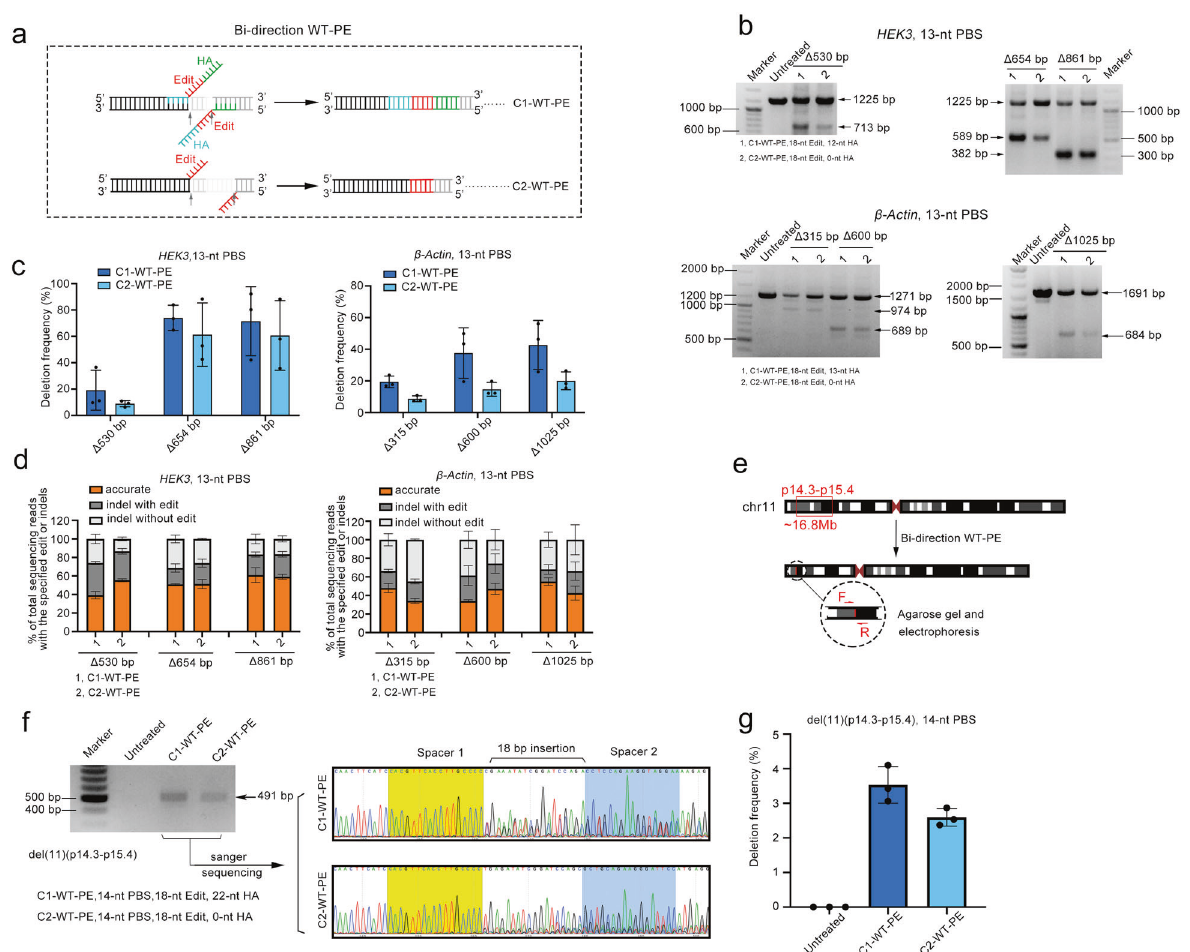
Fig. 2 Targeted large fragment deletion by bi-directional WT-PE (bi-WT-PE). a A diagram showing the design of bi-directional WT-PE for targeted deletion. A pair of pegRNAs were designed to target each side sequences (black) fl anking the aimed fragment to be deleted (gray). The RT template of each pegRNA in class 1 bi-directional WT-PE (C1-WT-PE) is designed to contain aimed edit (in red) and a homologous arm (HA, in green) that is complementary to the PAM proximal end of the target region of the other pegRNA (right panel). And the RT template of pegRNA in class 2 bi-directional WT-PE (C2-WT-PE) is designed to contain only the edits but complementary with each other. b Agarose gel analysis of the amplicons of targeted deletions. A pair of primers fl anking each target deletion were used to amplify the edited region. Bands with size match wild type or edited sequences were indicated. Parameters of pegRNA, including the length of edit and HA were indicated below the gel image. c Quanti fi cation of the targeted deletion by photoshop software analysis of the band intensity. d HTS analysis of the fragments containing aimed deletions. Three types of editing outcomes were observed in WT-PE mediated deletions and their relative ratios were quanti fi ed via HTS. Plots show mean ± s.d. of three independent biological replicates. e Diagram showing the design of a 16.8 Mbs deletion on the short arm of chromosome 11. f The presence of chromosome 11 with targeted deletions was detected by PCR analysis with primers indicated in Supplementary Table 4. Left panel showed the agarose gel image of the amplicons and right panel showed their Sanger sequencing chromatograms with residue spacer sequences marked with yellow and blue. g Quantifying the frequencies of targeted deletions by absolute quantitative PCR. The standard curves of wildtype- or edited-chromosome-speci fi c fragment were shown in supplementary Fig. 8. Plots showed mean ± s.d. of three independent biological